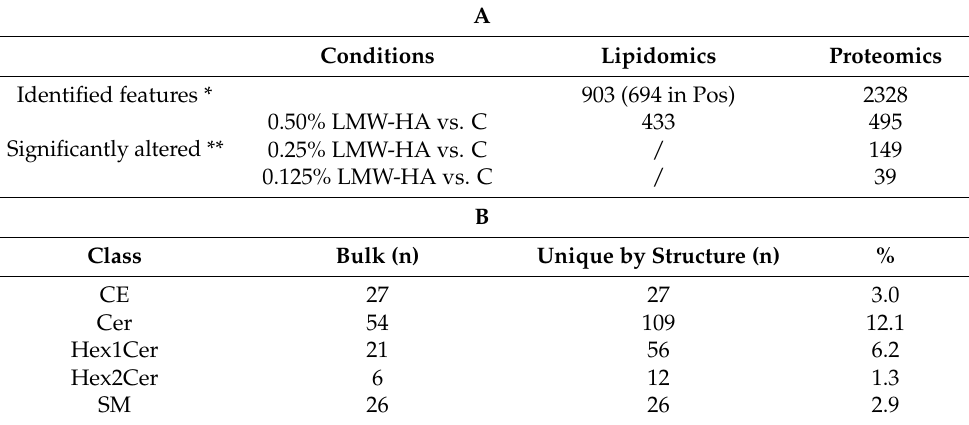
Table 1. ( A ) Summary of detected, filtered, and significantly altered features in lipidomics and pro- teomics analyses [10]; * unique by structure, ** Volcano plot; FC > 2, p value < 0.05; ( B ) Total identified lipids at bulk and structure level divided by classes; CE = cholesterol esters, Cer = ceramides,